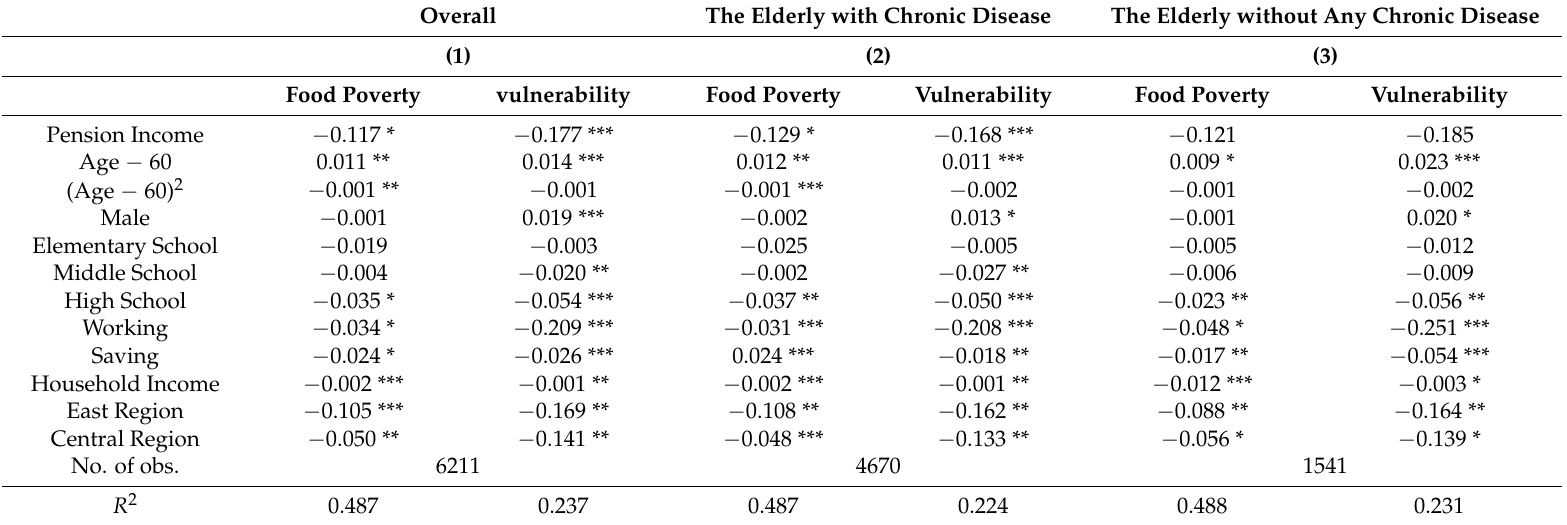
Table 4. Effects of pension income on food poverty and